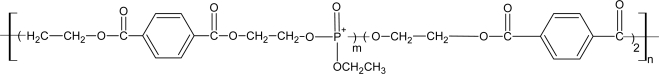
Structure of PoliterefateTM [23].